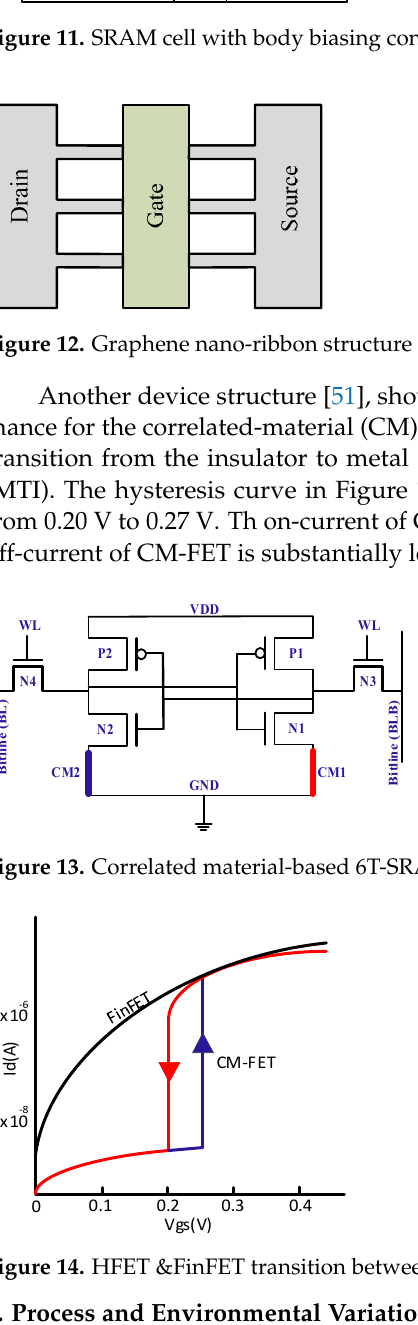
Figure 11. SRAM cell with body biasing control circuit [48].